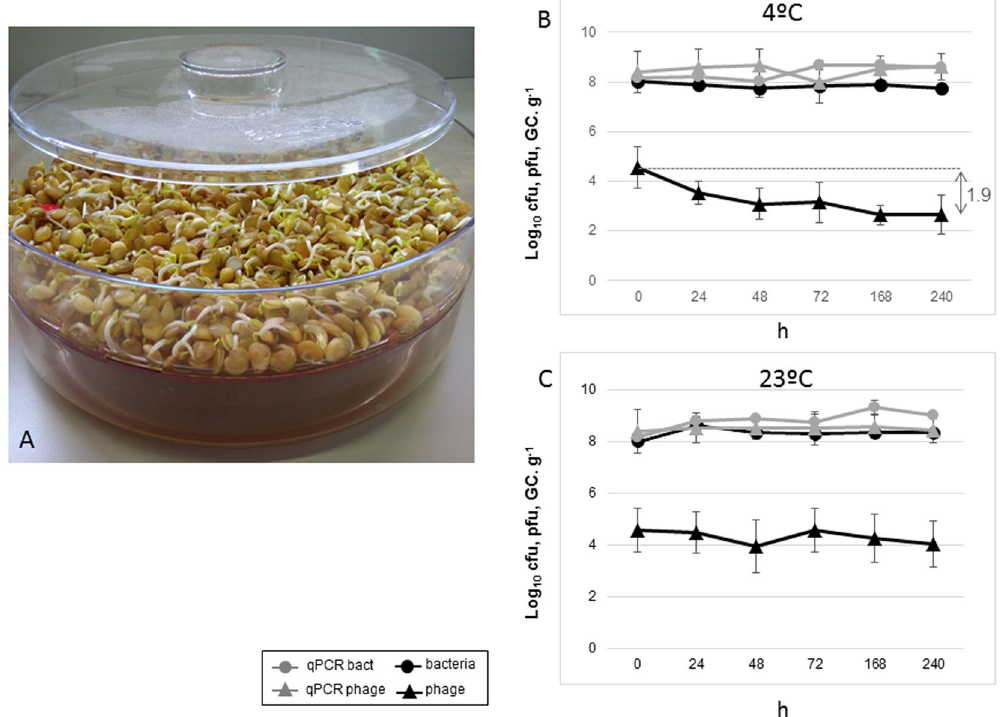
Figure 4. ( A ) Laboratory production of lentil sprouts in the germinator at 23 °C. ( B ) Stability of 933W and E . coli C600 (933W ∆ stx :: gfp - cat ) in the sprouts after 10 days of storage at 4 °C. ( C ) Stability of 933W and E . coli C600 (933W ∆ stx :: gfp - cat ) in the sprouts after 10 days of storage at 23 °C. Culturable bacteria (log 10 cfug − 1 ). Infectious Stx phages (log 10 pfug − 1 ). Phage and bacterial genomes were evaluated by qPCR (log 10 GC.g − 1 ). All results are the mean of three independent experiments. For each replicate, different sprouts were produced and used. Those microorganisms showing significant ( P < 0.05) reductions are indicated by a vertical arrow.